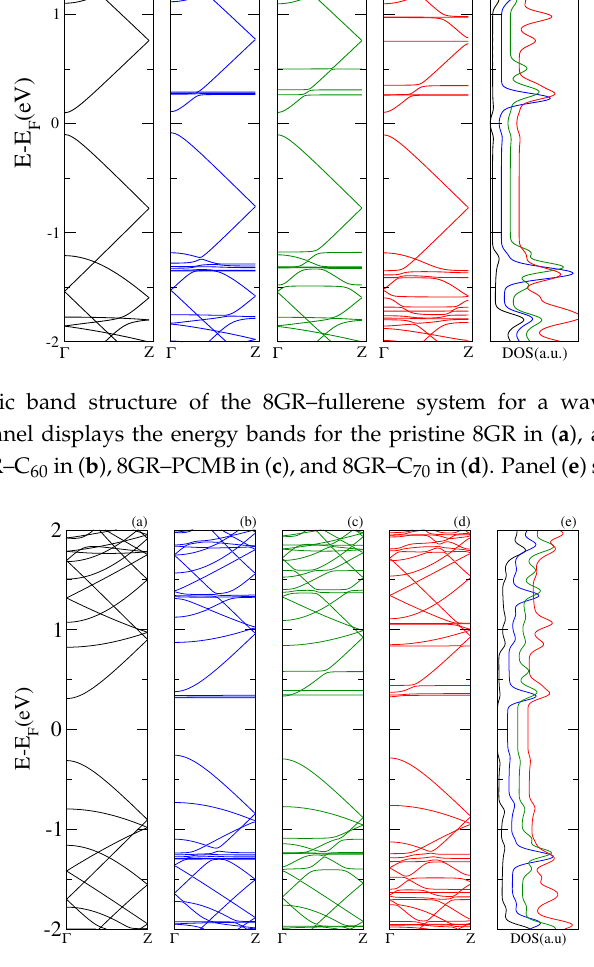
Figure 4. Electronic band structure of the 12GR–fullerene system for a wave vector along the z direction. Each panel displays the energy bands for the pristine 12GR in ( a ), and for the different hybrid systems: 12GR–C 60 in ( b ), 12GR–PCMB in ( c ), and 12GR–C 70 in ( d ). Panel ( e ) shows the total